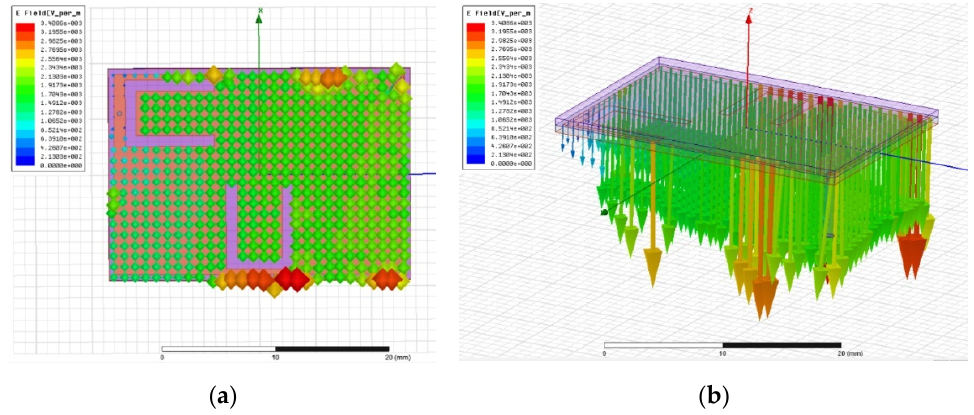
Figure 17. Electric field distribution of the proposed antenna at 402.5 MHz displayed in two- dimensional ( a ) and three-dimensional space ( b ) as displayed from our simulations.